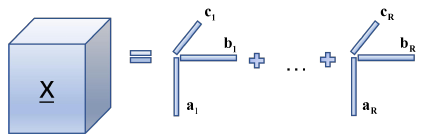
Figure 1. Canonical polyadic decomposition